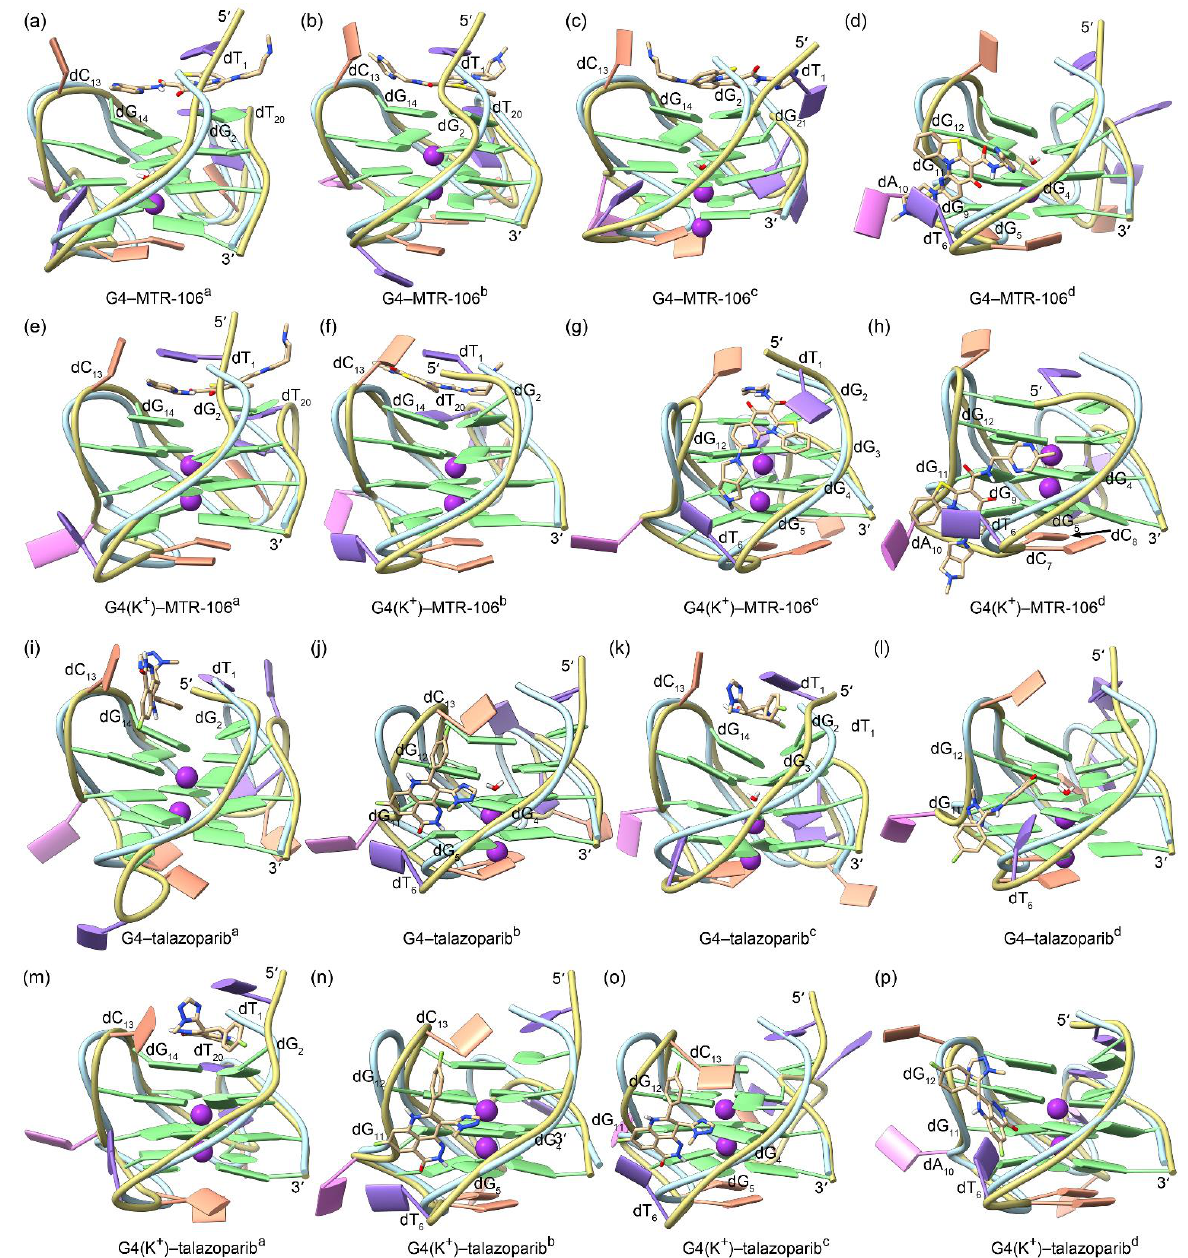
Figure 4. The MD-equilibrated conformations of the PARP1 G4/G4(K + )–MTR-106/talazoparib-binding complexes. For comparison, the structure of NMR PARP1 G4 is shown as a light-blue ribbon in each panel. The nucleotides that formed close interactions with the binding ligands are labeled.